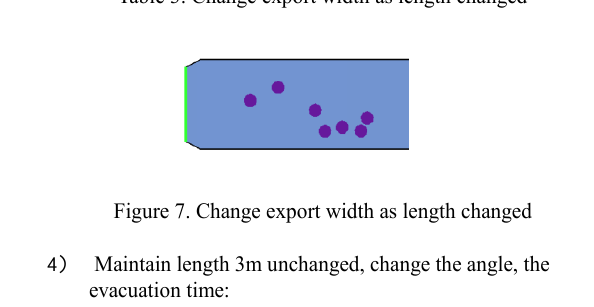
Figure 7. Change export width as length changed